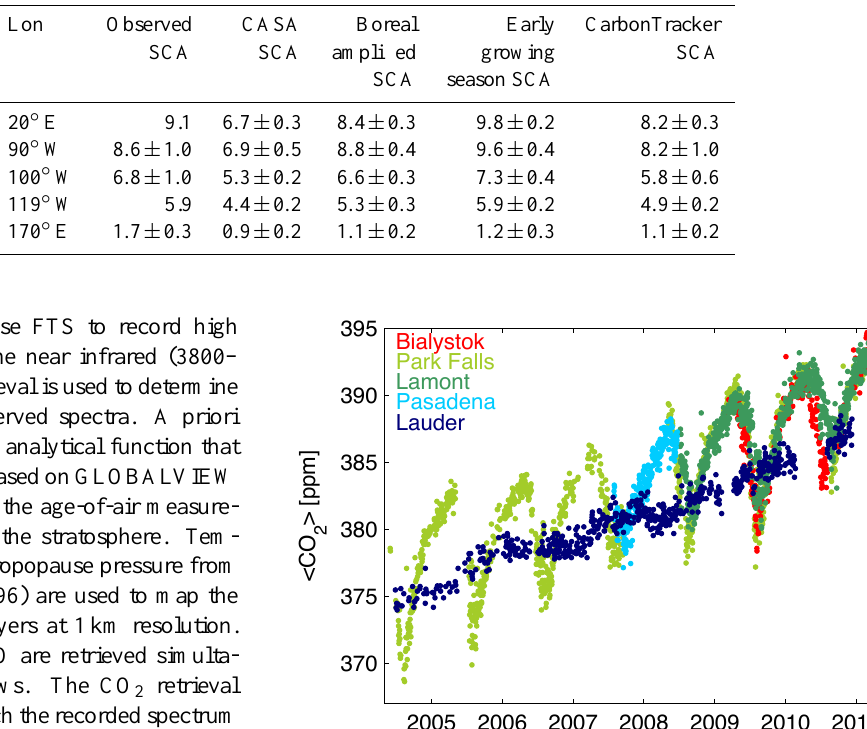
Table 1. TCCON sites and their median seasonal cycle amplitudes (SCA) in ppm.